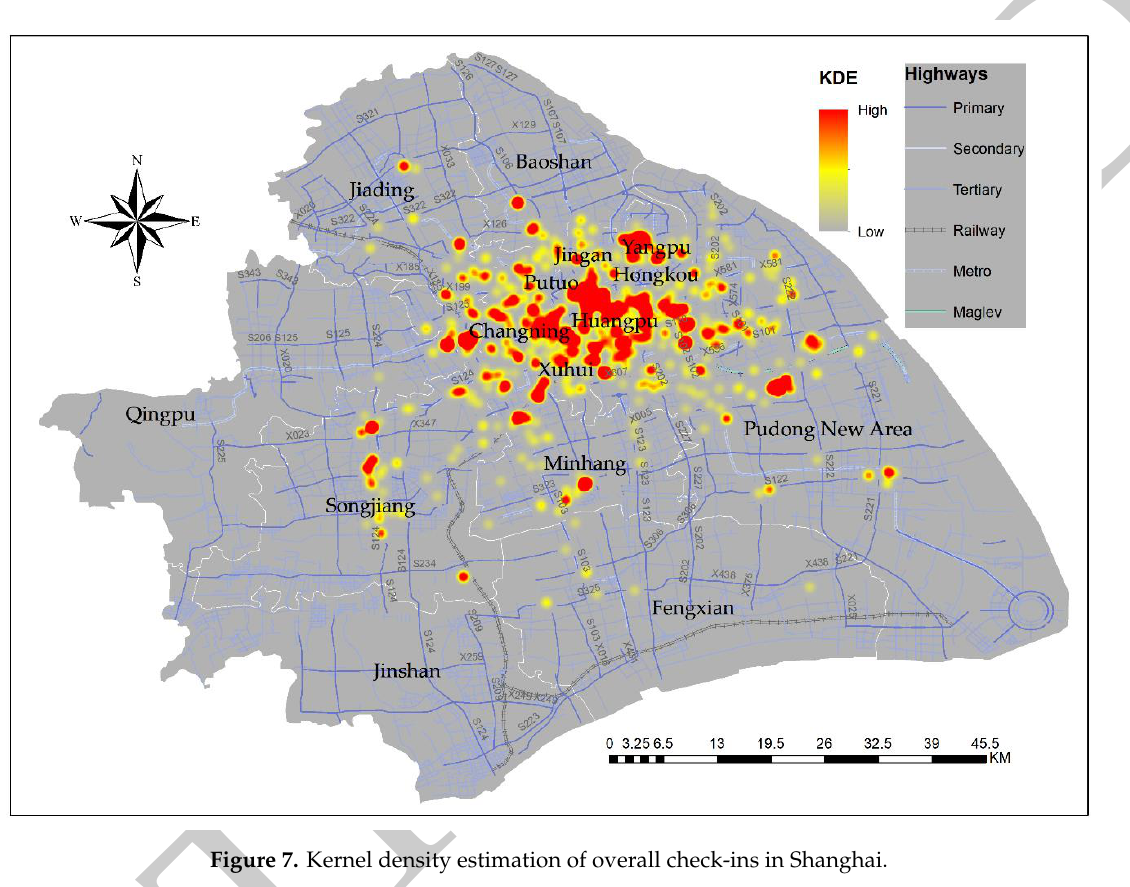
Figure 7. Kernel density estimation of overall check-ins in Shanghai.